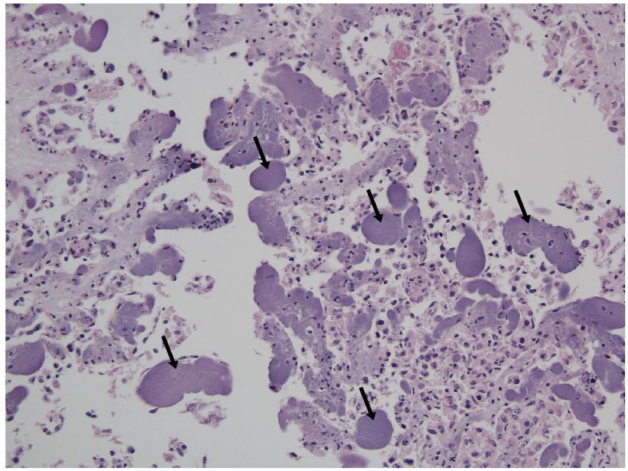
A representative hematoxylin and eosin (H&E) stain of placenta tissue with the subtrophoblastic capillaries distended by large numbers of intracytoplasmic bacteria typical of Campylobacter